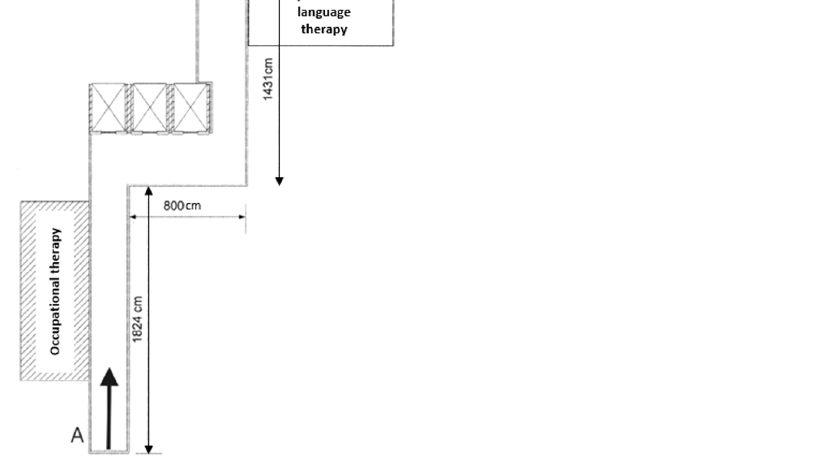
Figure 3. Example of wheelchair navigation course taken from Ceyte et al. (2019) [21].